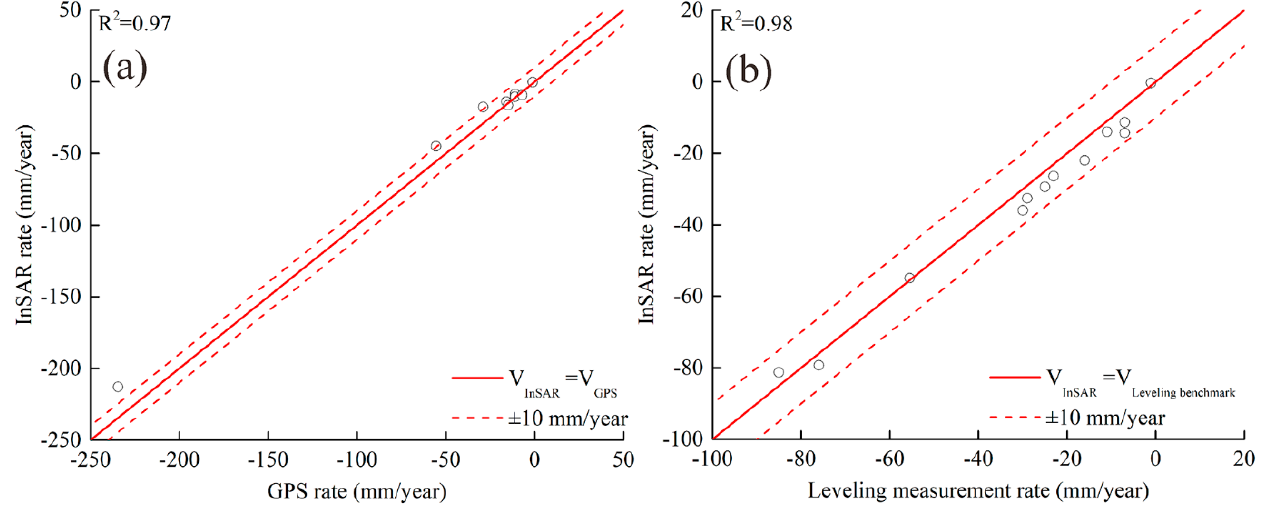
Figure 6. ( a ) Comparisons of land subsidence rates derived via the PS-InSAR technique and Global Positioning System (GPS) measurement. One circle corresponds to one comparison between two monitoring results. ( b ) Comparisons of land subsidence rates derived via the PS-InSAR technique and leveling measurement. One circle corresponds to one comparison between two monitoring results.